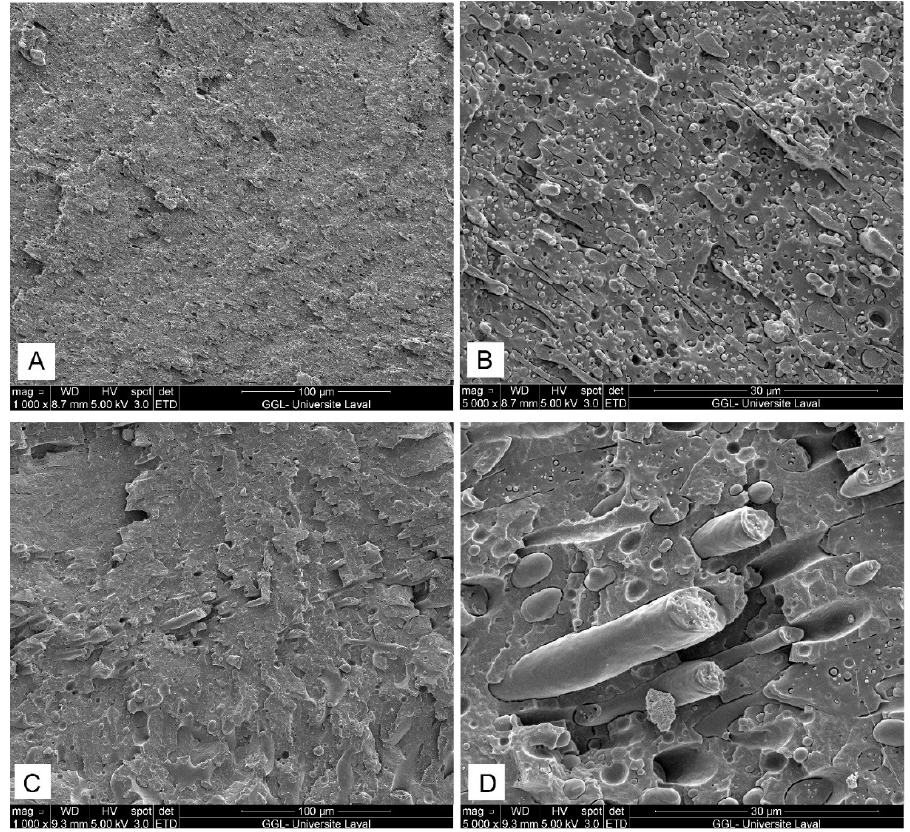
Figure 2. SEM micrographs of PL70/PA30 ( A , B ) and PL50/PA50 ( C , D ) blends (see Section 3.2 for defini-